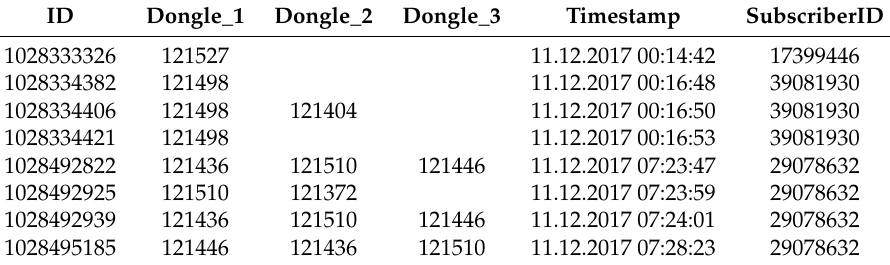
Table 3. An example of an event log created from iBeacon